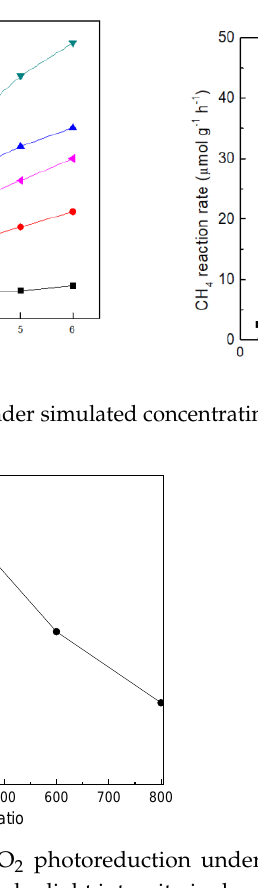
Figure 10. Reaction rate of CO 2 photoreduction under concentrating solar light. Hangzhou, AM10:30-PM2:30. The average solar light intensity is about 60 mW/cm 2 .